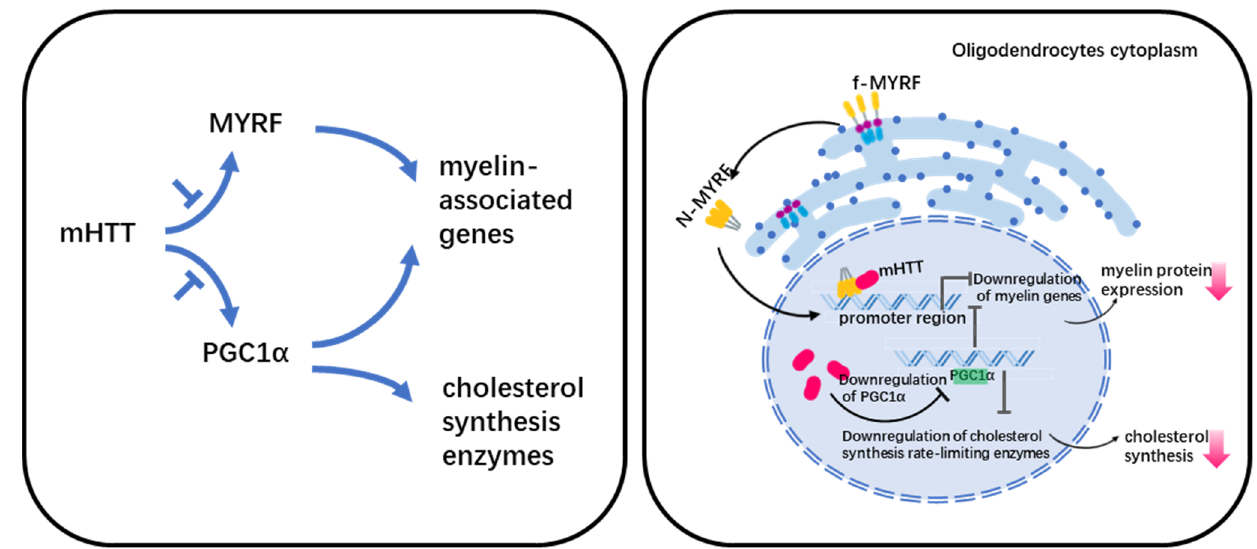
Figure 1. Legend. Potential mechanism of myelin defect in HD.